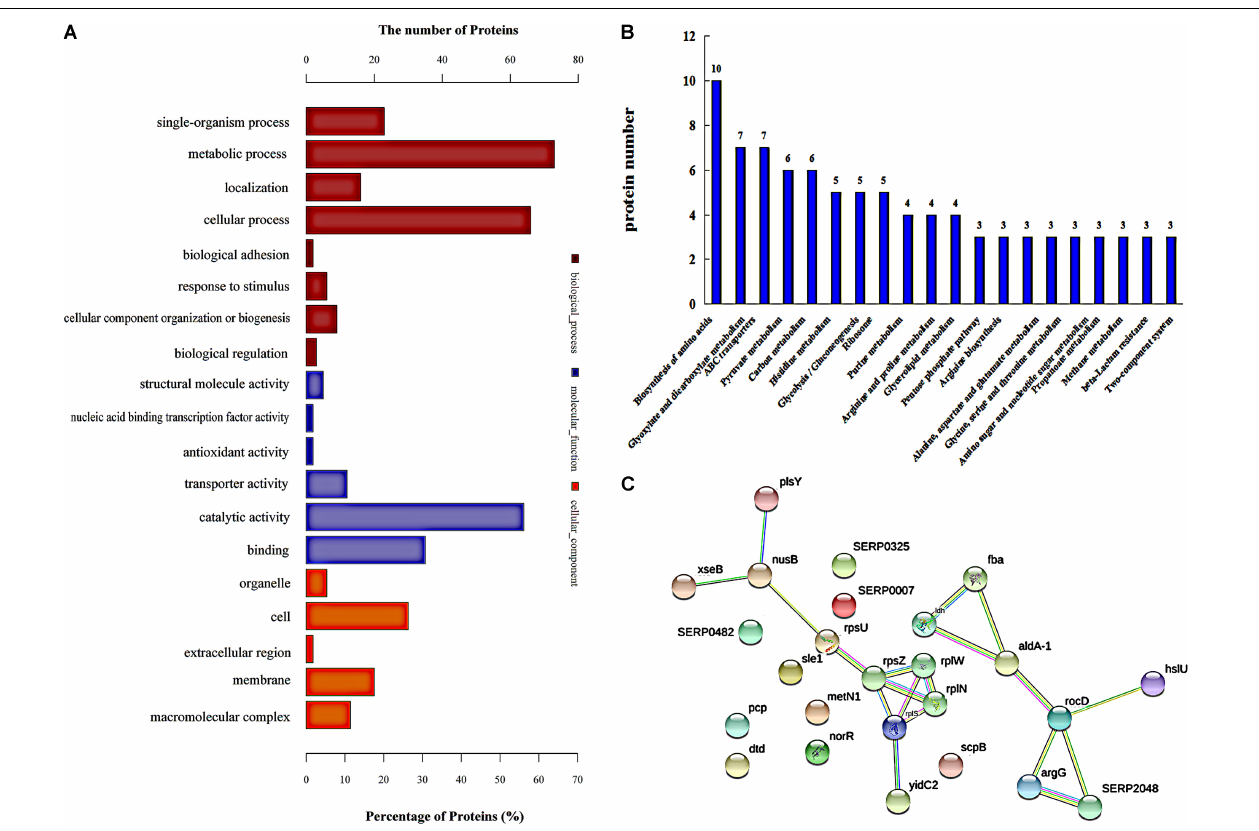
Figure 2 | Protein expression analysis. (A) Functional annotation of differentially regulated proteins by using Gene Ontology (go). (B) Proteins involved in KEGG pathways, and showing a significant difference. (C) The network of significantly differentially expressed proteins was analyzed using String. The nodes represent proteins; the blue lines represent database evidence; pink lines represent experimental evidence; yellow lines represent mining evidence; black lines represent evidence of co-expression; and green lines represent neighborhood